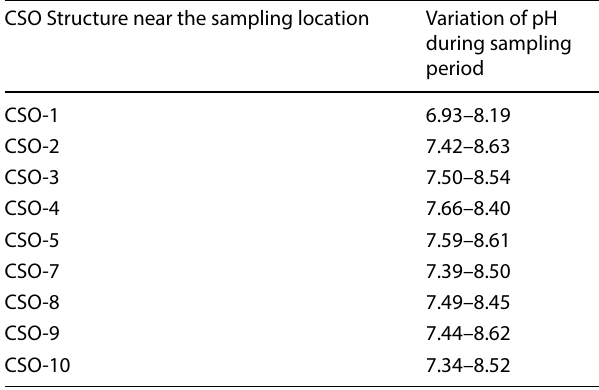
Table 3 Variation of pH at the sampling locations during the sam- pling period CSO Structure near the sampling location Variation of pH